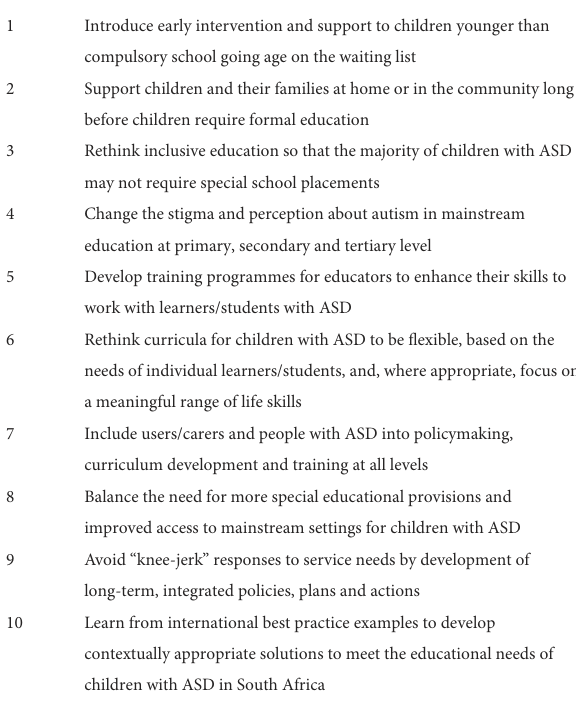
TABLE 3 Participant recommendations for service strengthening of ASD education in the Western Cape.